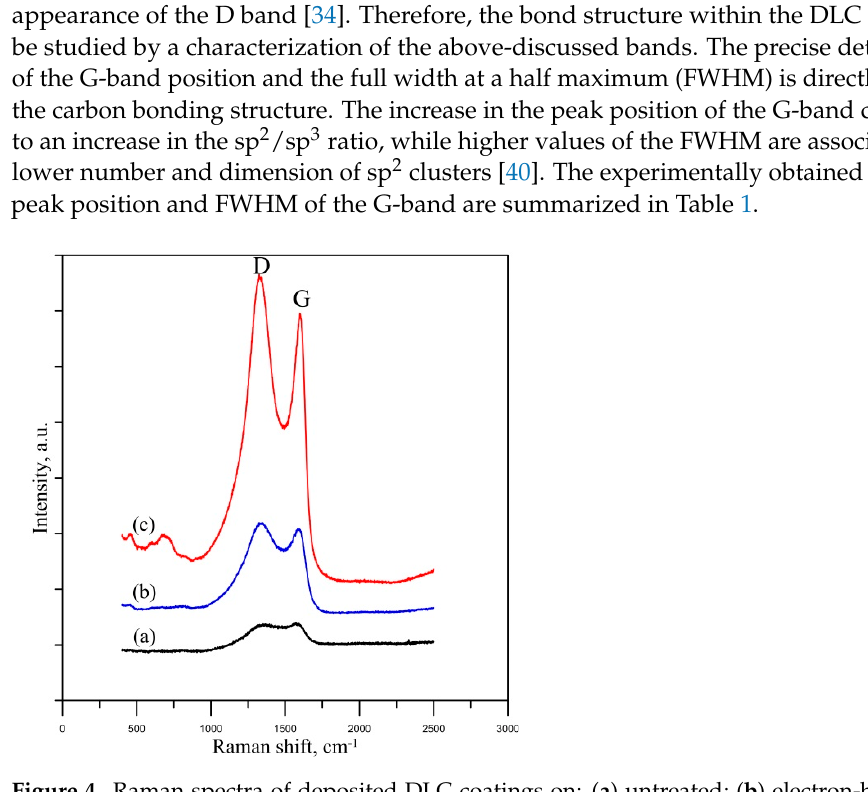
Figure 4. Raman spectra of deposited DLC coatings on: ( a ) untreated; ( b ) electron-beam-treated substrates at 1000 W, and ( c ) electron-beam-treated substrates at 1500 W. Table 1. Peak position and FWHM of the G-band.